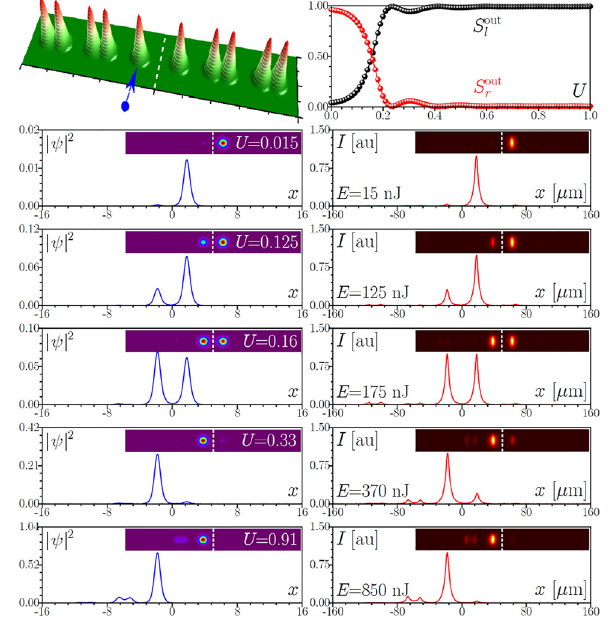
Figure 3: Same as in Figure 2, but for the larger spacing h = 36 μ m between two topological